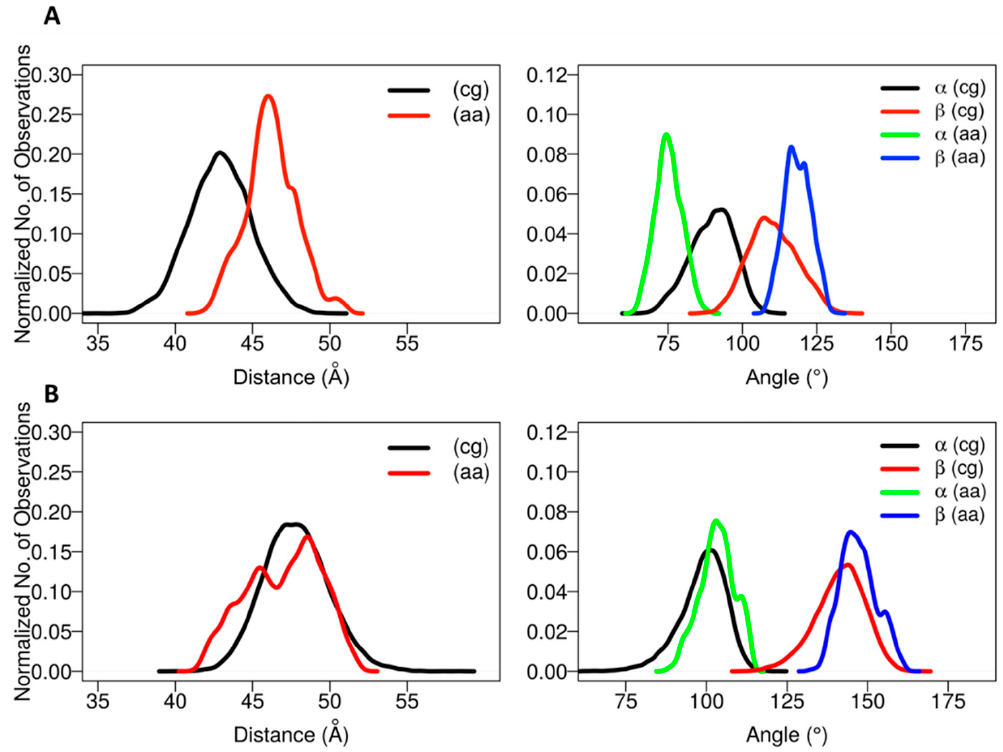
Figure 4. Plots of the distance and angle distributions defining the positioning of the globular domain with respect to the membrane in CG and AA MD simulations of CYP 2C9 ( A ) and CYP 2C19 ( B ). The globular domain of CYP 2C9 tended to be more immersed in the membrane than CYP 2C19 and the two adopted distinct orientations: class A (angle β < 125 ◦ ) for CYP 2C9, and class B (angle β > 130 ◦ ) for CYP 2C19.